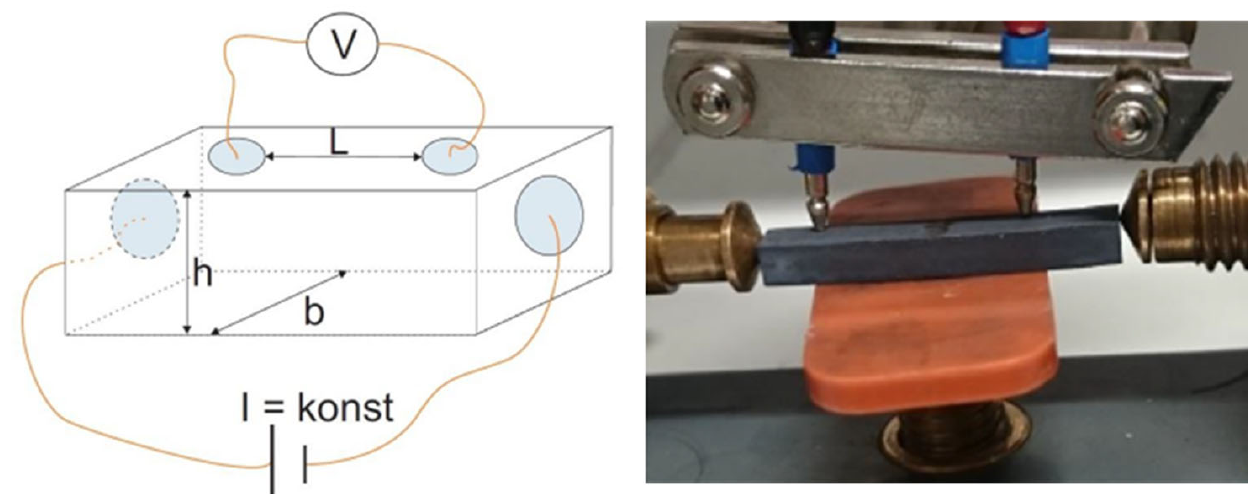
Figure 2. Four-point method for measuring the electrical conductivity with change of polarization. TiO x rods with different cross-sectional edge lengths (h and b; in our case h = b = 1 mm, 2 mm or 3 mm) sintered by using the developed profile (1400 ◦ C) were clamped between the two lateral contacts for this purpose. By placing the two upper points on the